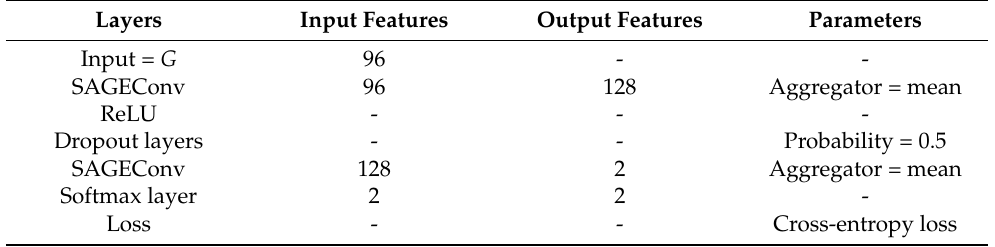
Table A1. The GraphSAGE network architecture used in this study, which was a two-layer network with one dropout